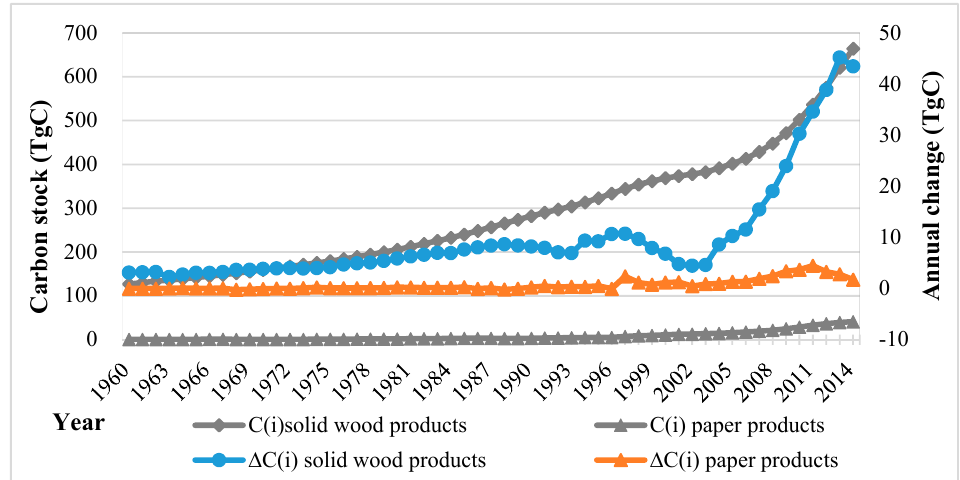
Figure 3. Carbon stock and annual change of two categories of HWP from harvest in China from 1960 to 2014.